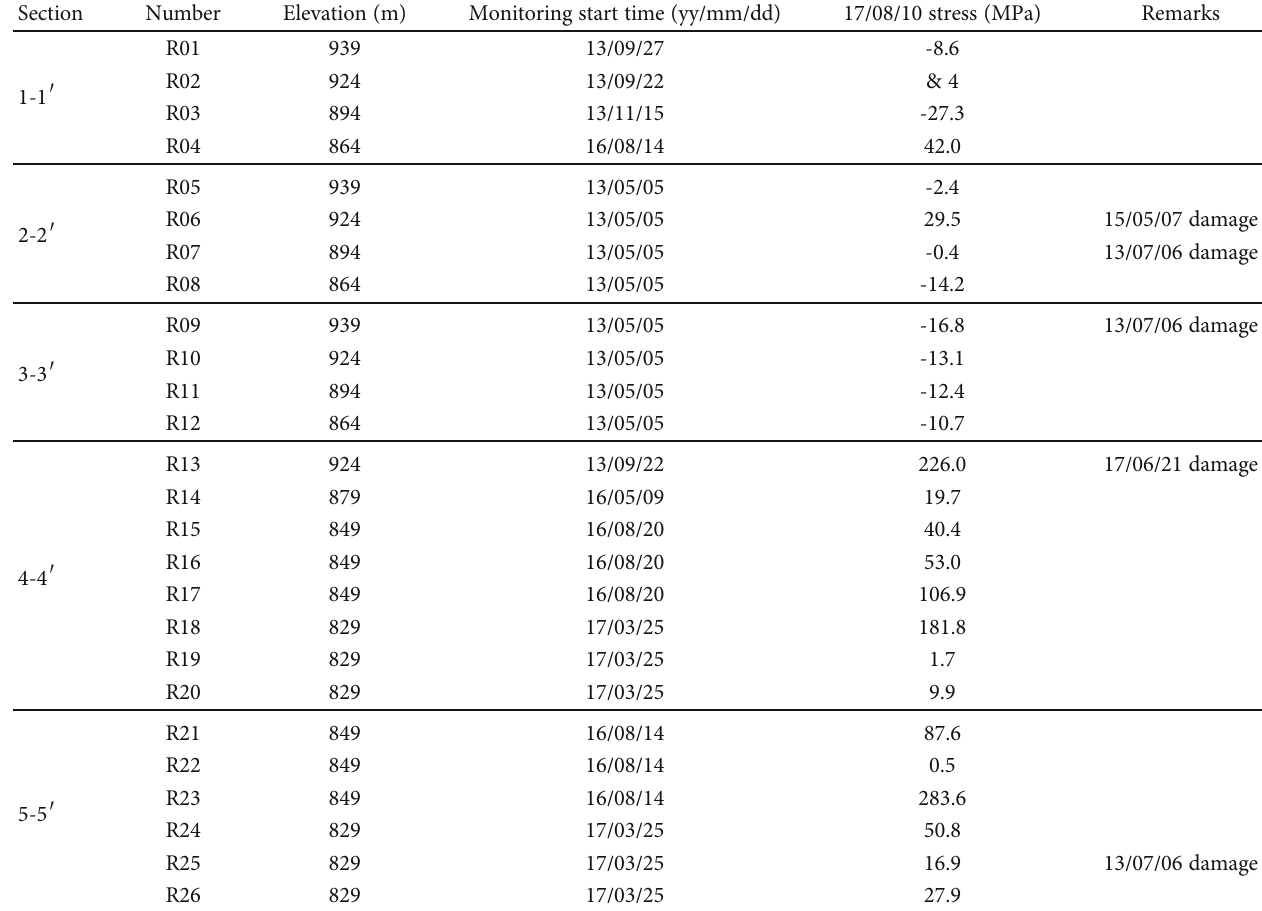
Table 3: Anchor stress meter monitoring